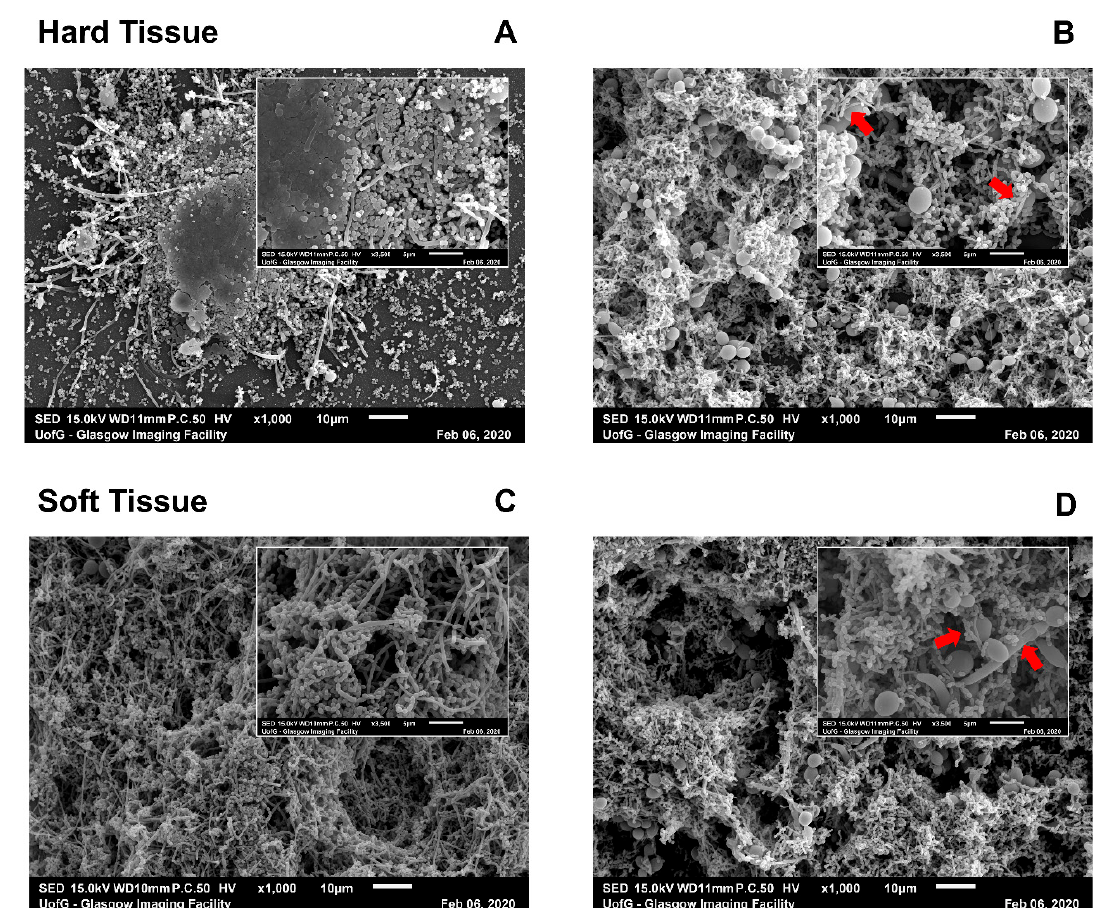
Figure 3. SEM images of hard tissue (HT) and soft tissue (ST) biofilms with or without C. albicans . Biofilms were processed after maturation and viewed on a JEOL JSM-6400 scanning electron microscope. Images were captured at ×1000 magnification (main image) and ×3500 magnification (inset). HT ( A , B ) and ST biofilms ( C , D ) were imaged without ( A , C ) and with C. albicans ( B , D ). Red arrows in insets of Candida -containing biofilms indicated visible attachment of bacterial cells with fungal hyphae or yeast cells. Images chosen were representative of duplicate samples.